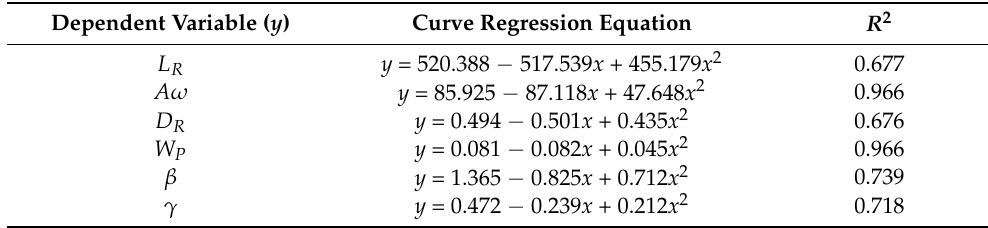
Table 8. Correlation between urbanization level and characteristic values of the river network water system structure. Dependent Variable ( y ) Curve Regression Equation R 2 L R y = 520.388 − 517.539 x + 455.179 x